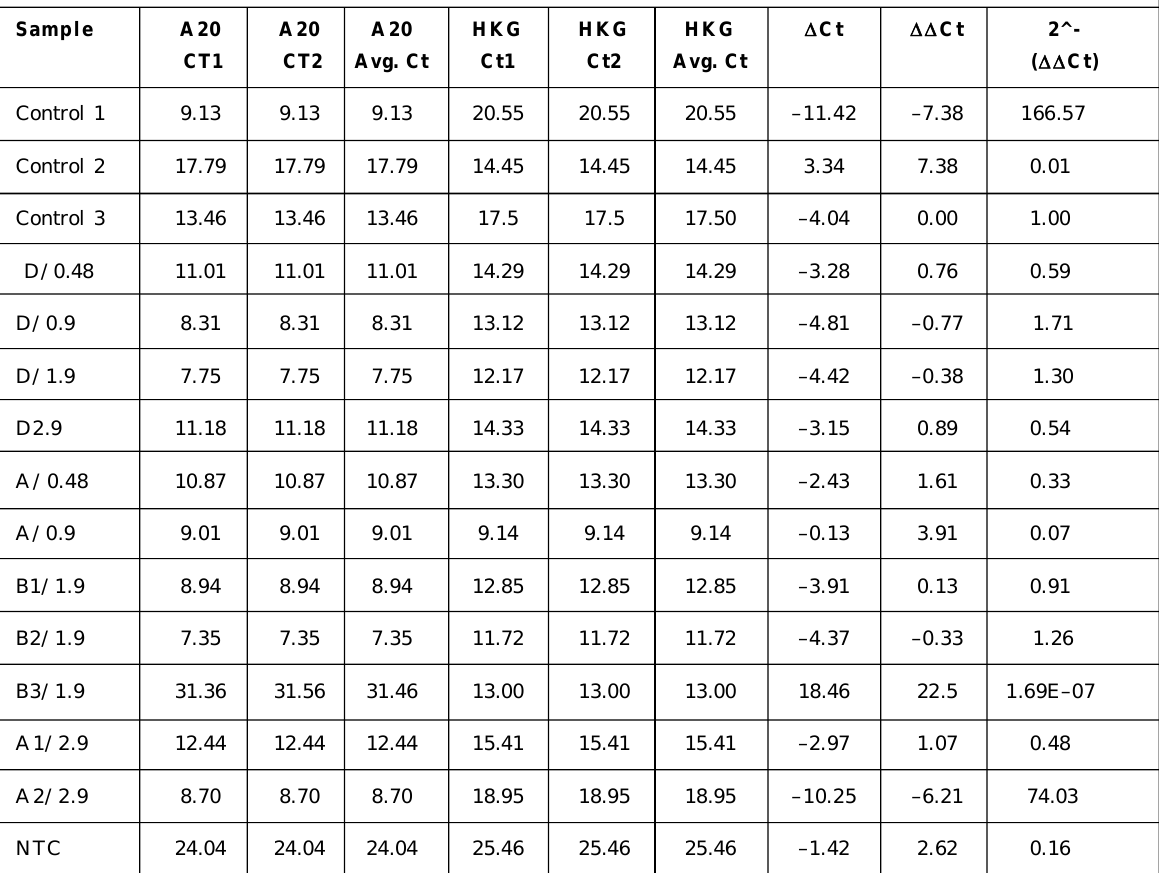
Table 5: Calculated 2–  CT for LmcesA20 primers with respect to the gene of interest and housekeeping gene (B-actin2)